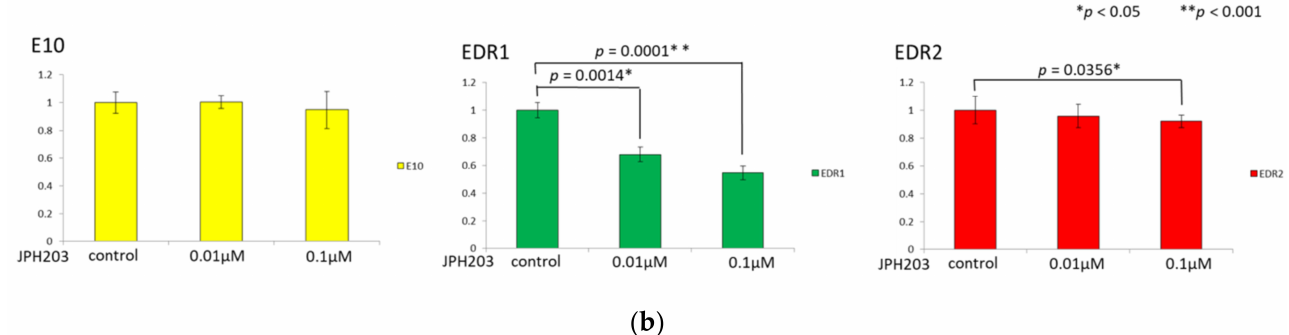
Figure 5. Cell proliferation in three breast cancer cell lines under nutrient stress ( a ). Cell proliferation in three breast cancer cell lines with 0, 0.01, and 0.1 µ M JPH203 for 24 h ( b ). The data was analyzed by the Student’s t -test. * p < 0.05, ** p <